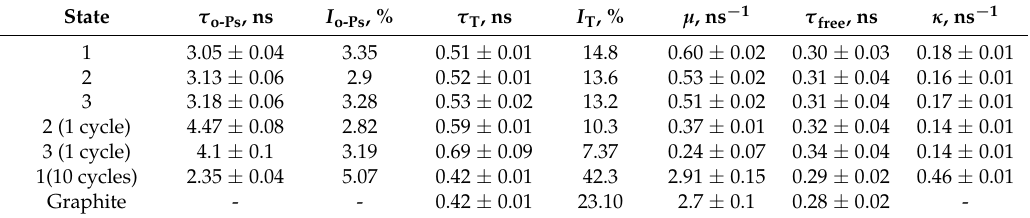
Table 2. The parameters of positron annihilation in the nanodiamonds before and after hydrogenation.